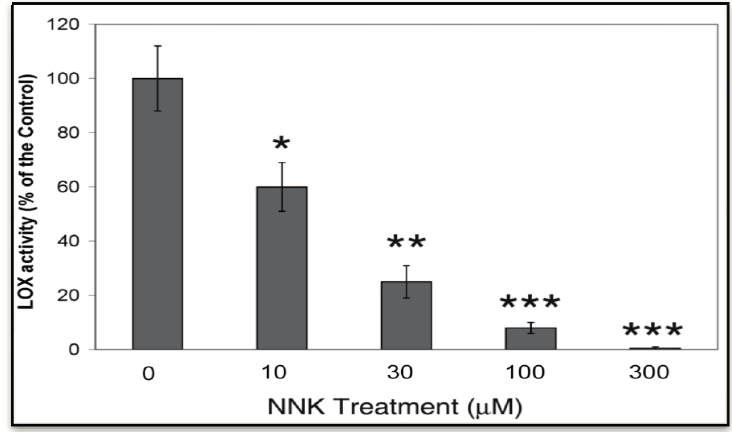
Figure 1. NNK inhibition of LOX activities in treated cells. Growth-arrested RFL6 cells were treated with NNK at 0–300 µM for 48 h. LOX catalytic levels were measured in the conditioned media with the fluorometric assay as described in the Experimental. Data shown are the mean ± SD ( n = 3). * p ≤ 0.05, ** p ≤ 0.01, *** p ≤ 0.001 compared with the